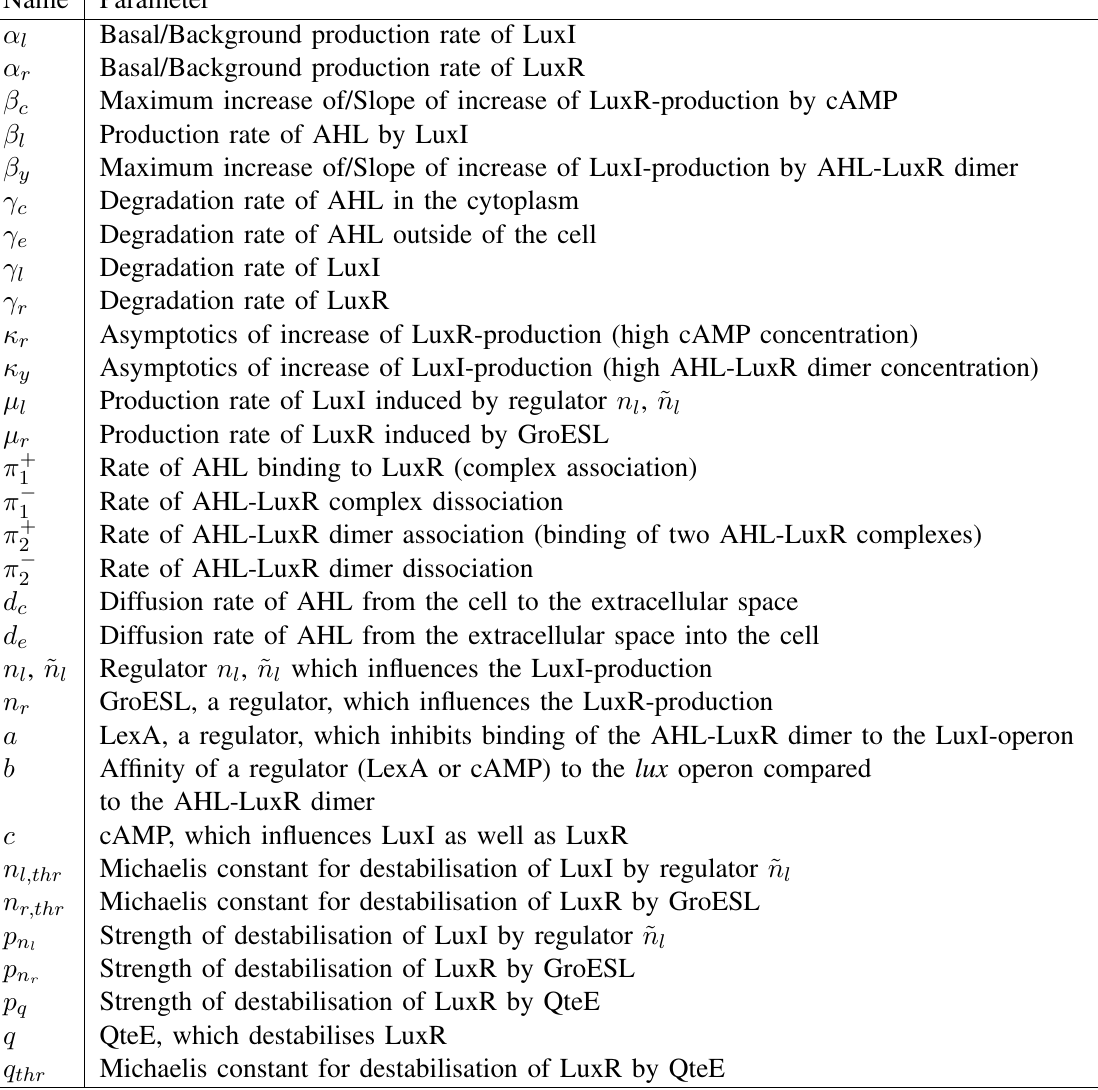
TABLE II: Model parameters of the basic and the modified Quorum sensing models